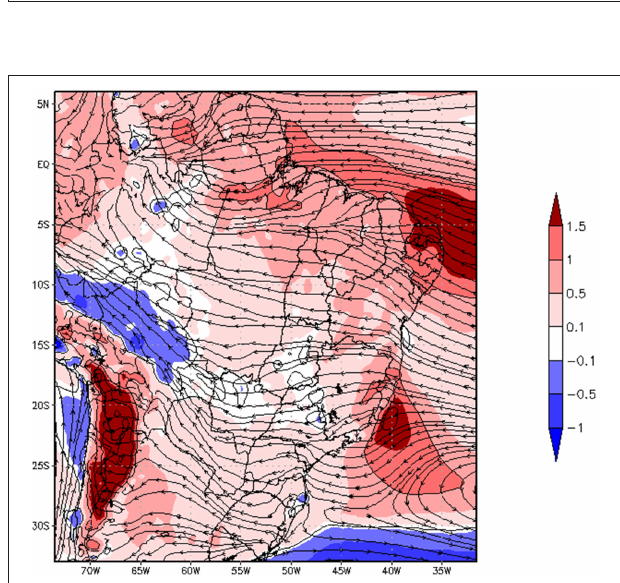
FIGURE 10 | Wind changes (m/s) for the period 2011–2040 relative to the climatological run 1960–1990. The wind currents represent the mean wind field for the period.